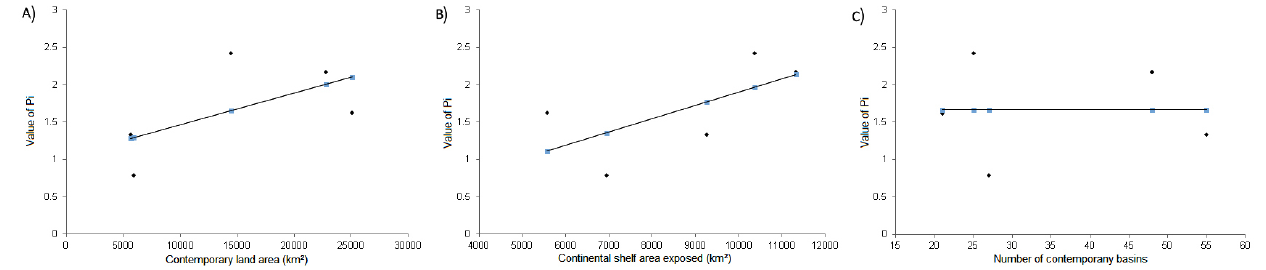
FIGURE 4 | Linear regression plots of the relationship between genetic diversity (mean number of pairwise differences π) and physical characteristics of paleodrainage (contemporary land area, continental shelf area exposed and number of contemporary basins) as described by Thomaz, Knowles, 2018 ( S2 ). A. Contemporary land area (R 2 = 0.90); B. Continental shelf area exposed (R 2 0.77); C. Number of contemporary basin (R 2 =